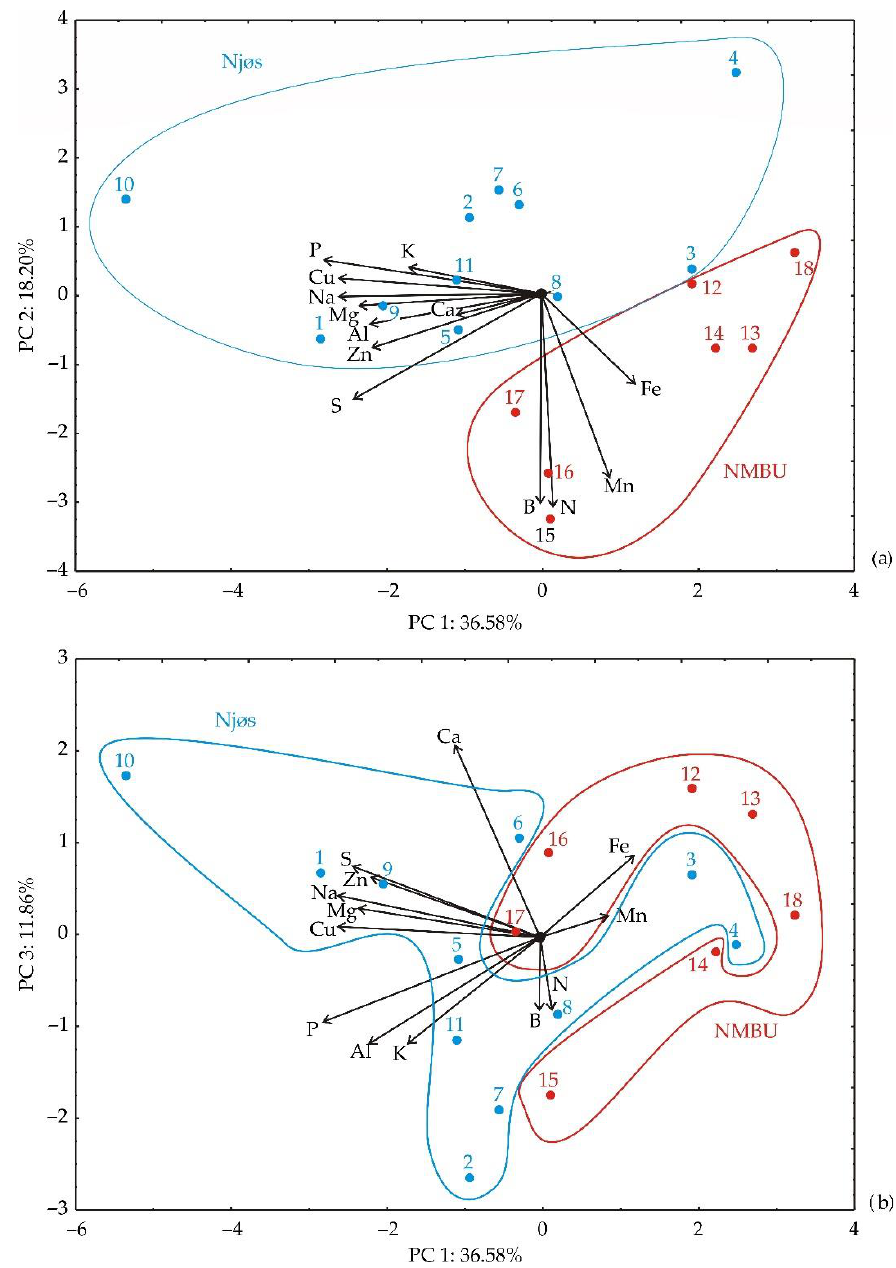
Figure 2. PCA ordination of element content variables: ( a ) projection in PC1-PC2 plane; ( b ) projection in PC1-PC3 plane.